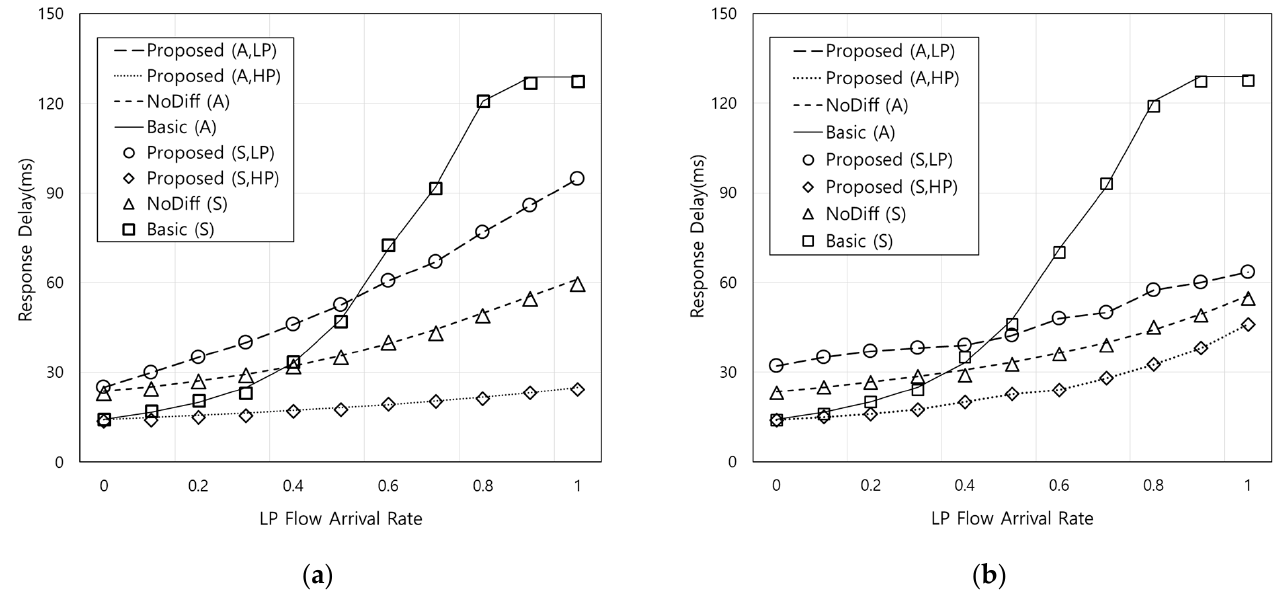
Figure 4. Response delay according to the LP flow arrival rate (A: analytic results, S: simulation results): ( a ) η = 1/3, ξ = 1/3, ( b ) η = 2/3, ξ = 1/3.